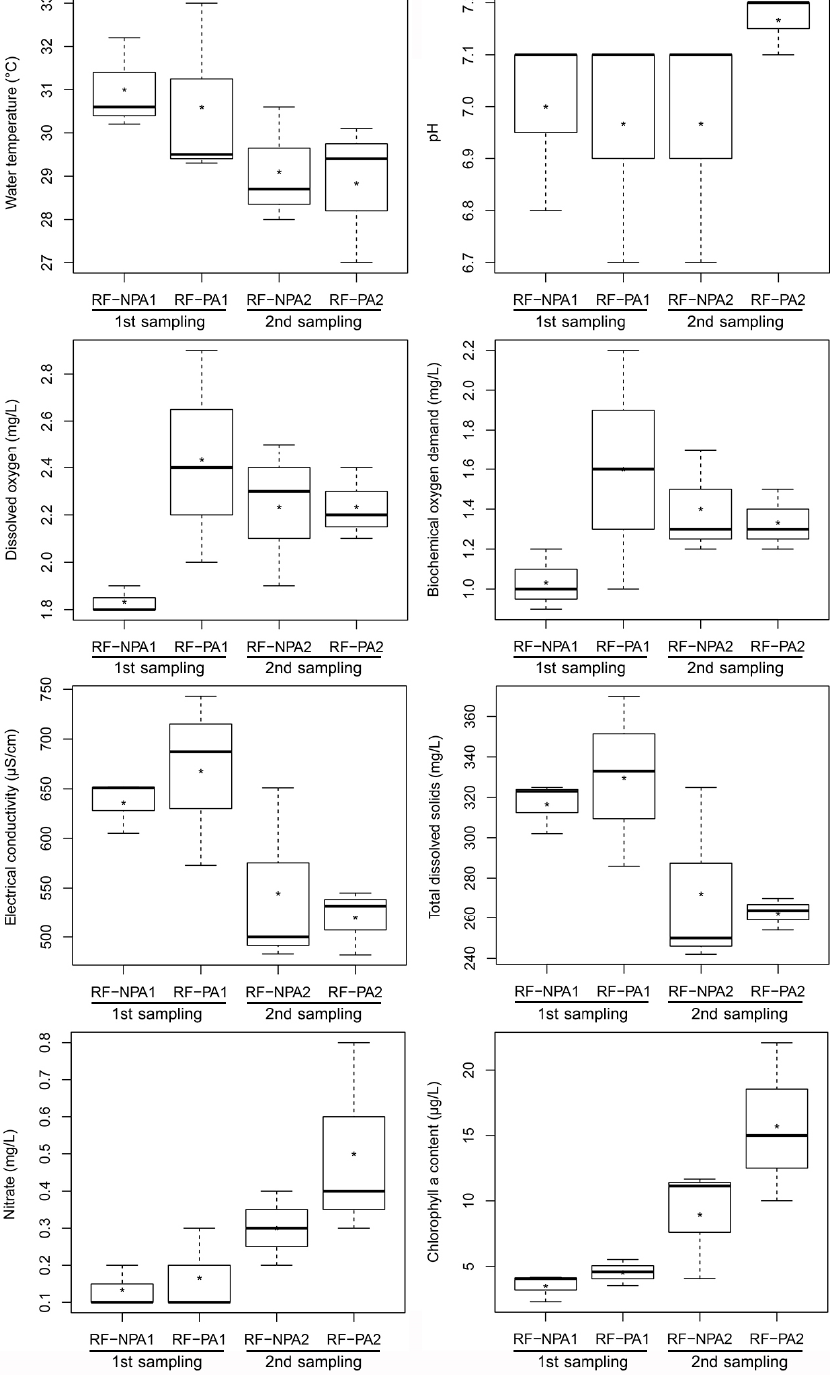
Figure 2. Boxplot comparisons of the eight environmental parameters of RF-NPA and RF-PA. NPA1, PA1, NPA2, and PA2 represent the first sampling RF-NPA, the first sampling RF-PA, the second sampling of RF-NPA, and the second sampling of RF-PA, respectively.